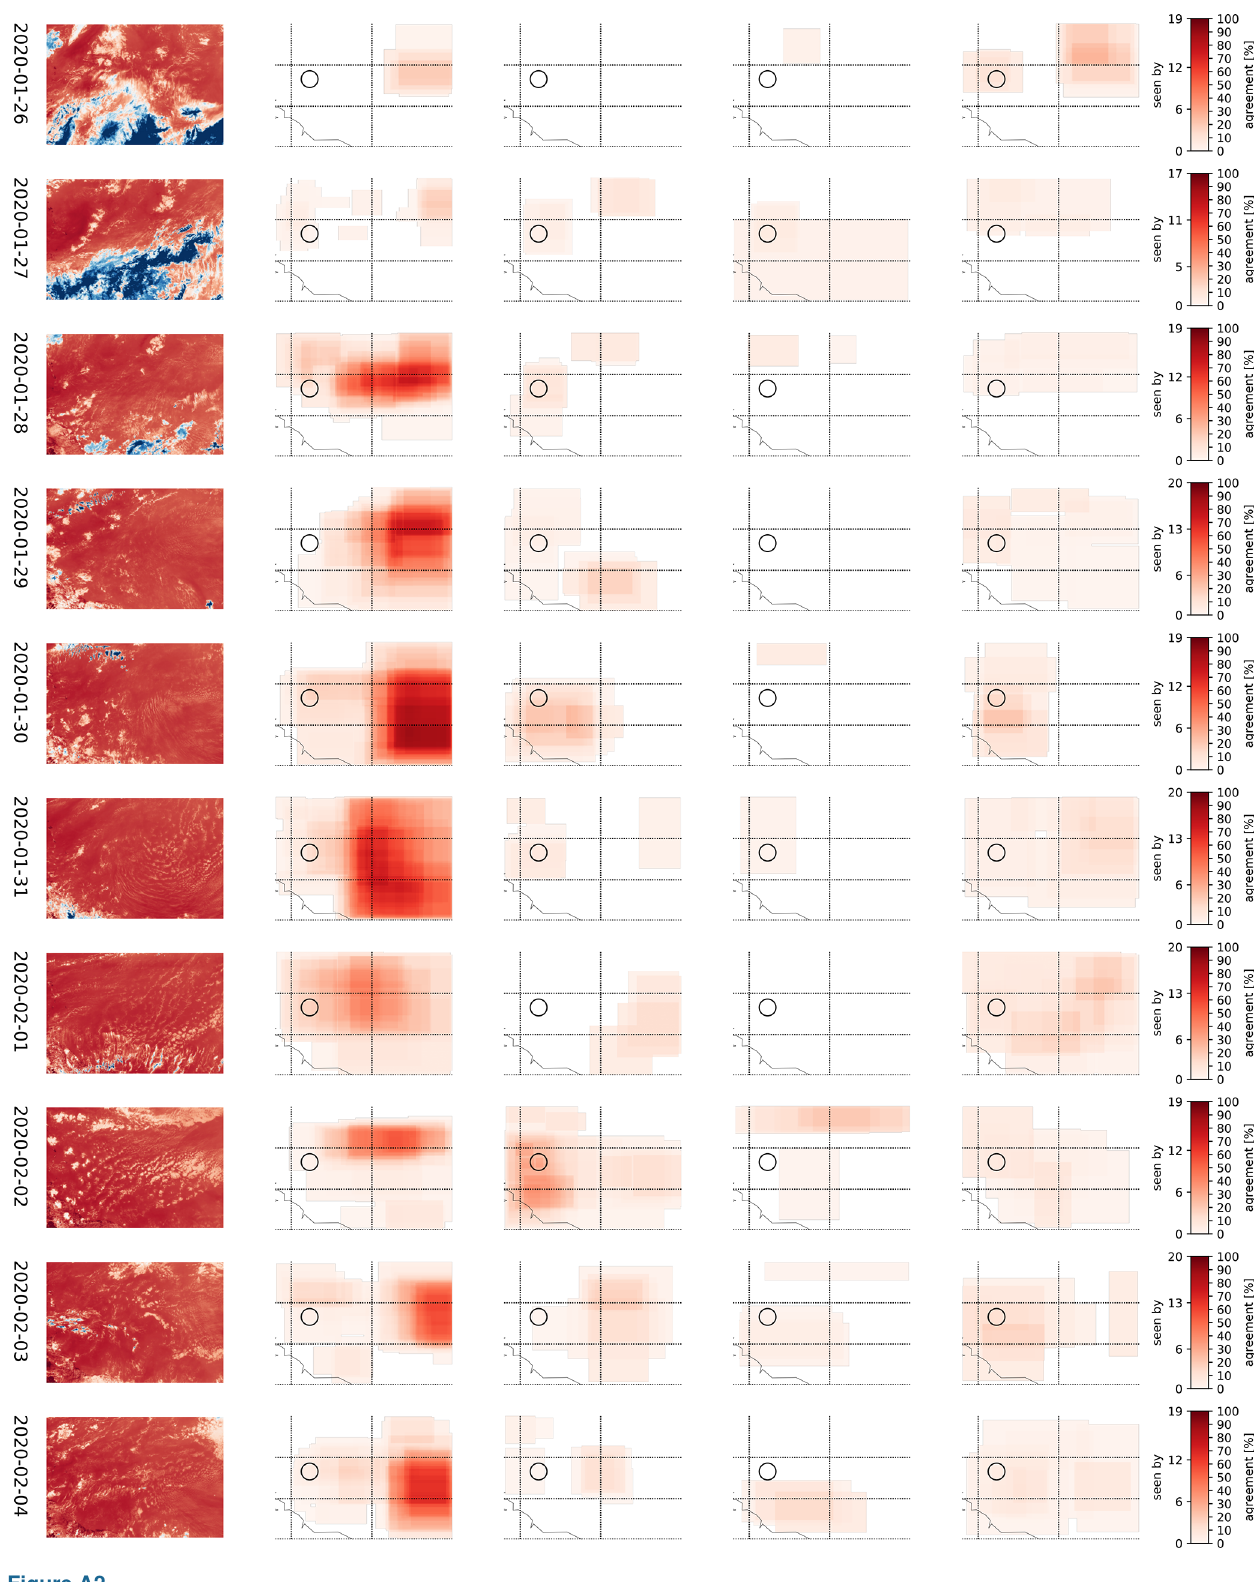
Earth Syst. Sci. Data, 14, 1233–1256,